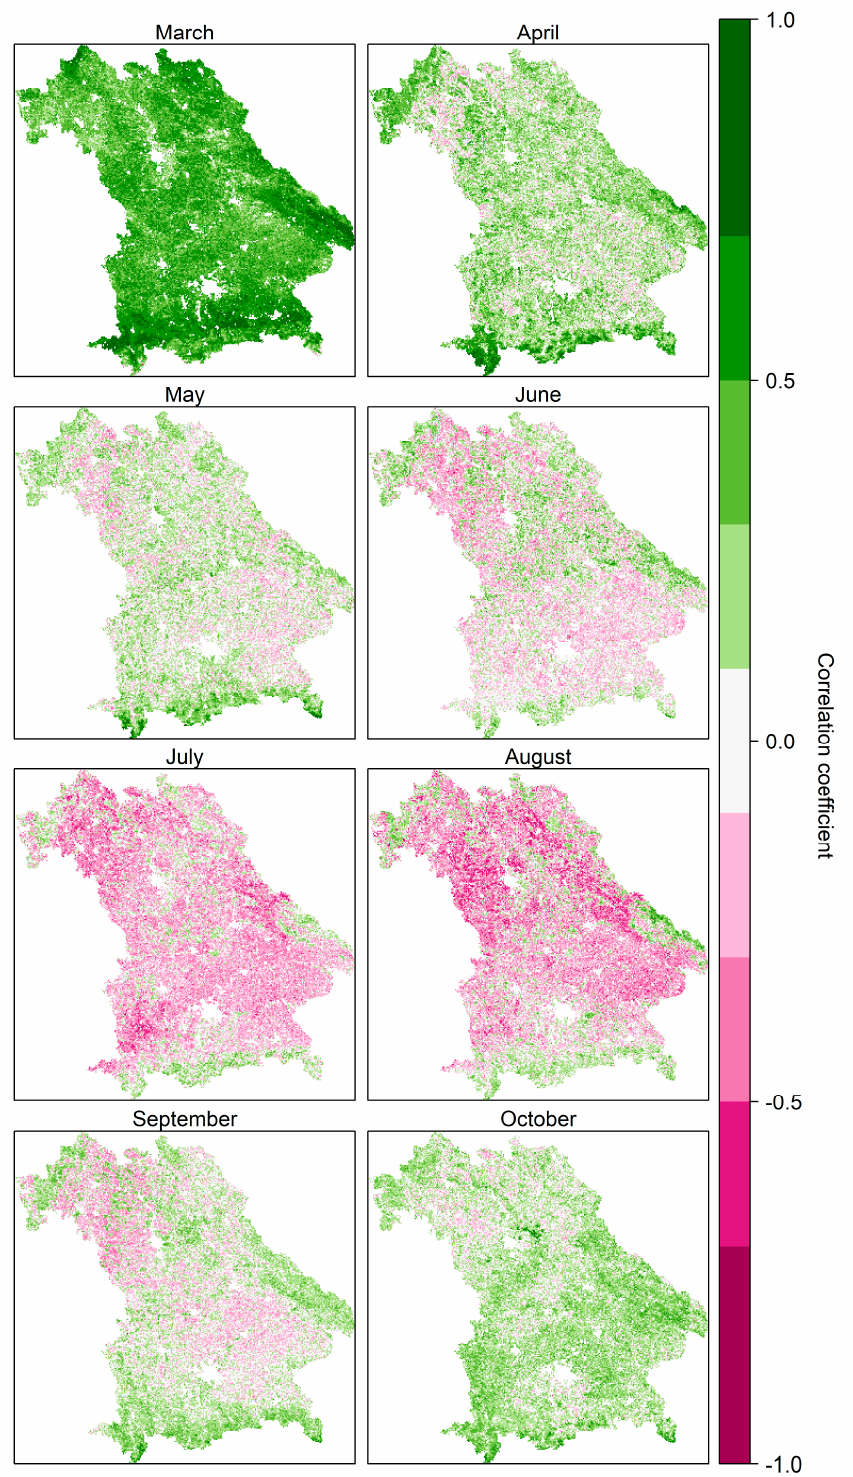
Figure 3. Pixel-based monthly correlation coefficients (Bravais-Pearson) between 8-day NDVI and LST in Bavaria from 2001 to 2020 during the vegetation period (March to October; corresponding p -values: Figure S4; corresponding scatterplots: Figure S5).